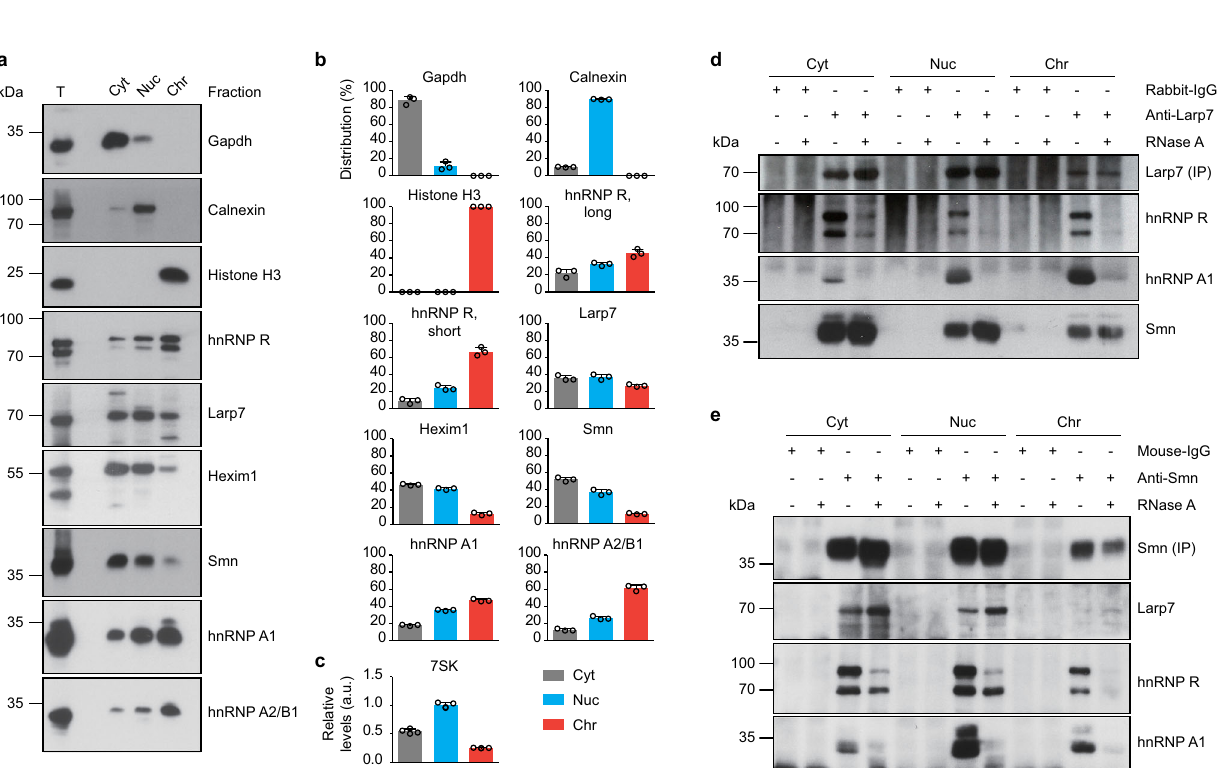
Fig. 4 Smn interacts with 7SK/hnRNP complexes in the nucleus and cytosol. a Western blot analysis of NSC-34 subcellular fractions. Cyt, cytosol; Nuc, nuclear soluble proteins and organelles; Chr, chromatin-associated proteins; T, total lysate. b Quanti fi cation of Western blot signals in a . Data are mean ± s. d. ( n = 3). c Quanti fi cation of 7SK RNA levels by qPCR. Data are mean ± s.d. ( n = 4). d Western blot analysis of proteins co-immunoprecipitated by anti- Larp7 from subcellular fractions of NSC-34 cells. Fractions were pretreated with RNase as indicated. e Same as in d but with anti-Smn. Source data are provided as a Source Data fi